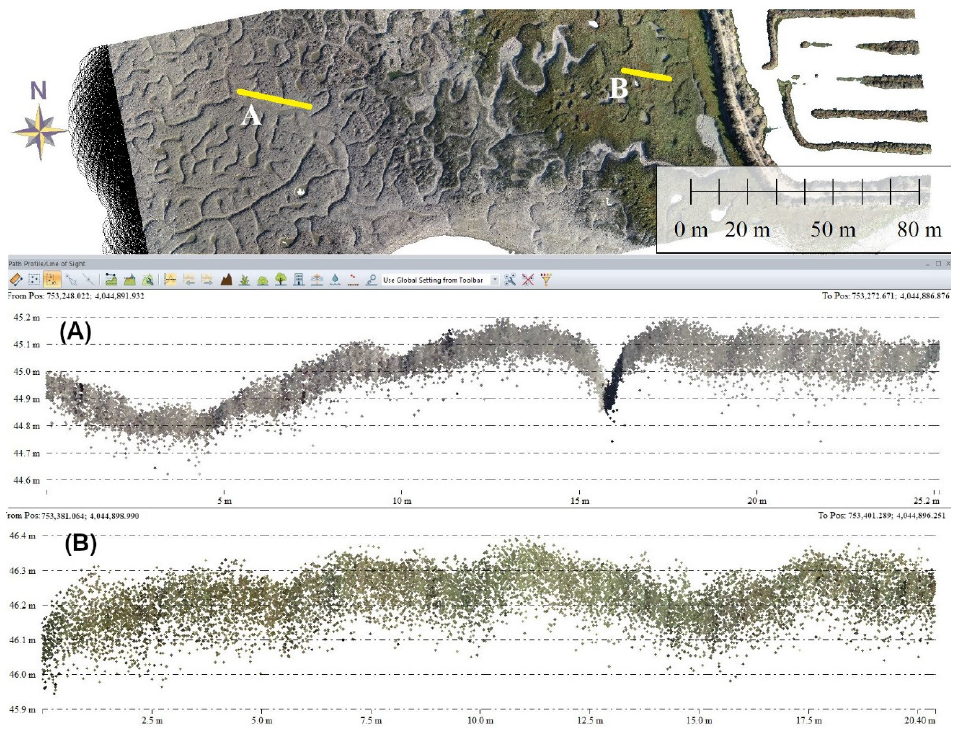
Figure 5. Profiles showing the thickness of the point cloud for bare ground ( A ) and vegetation ( B ).